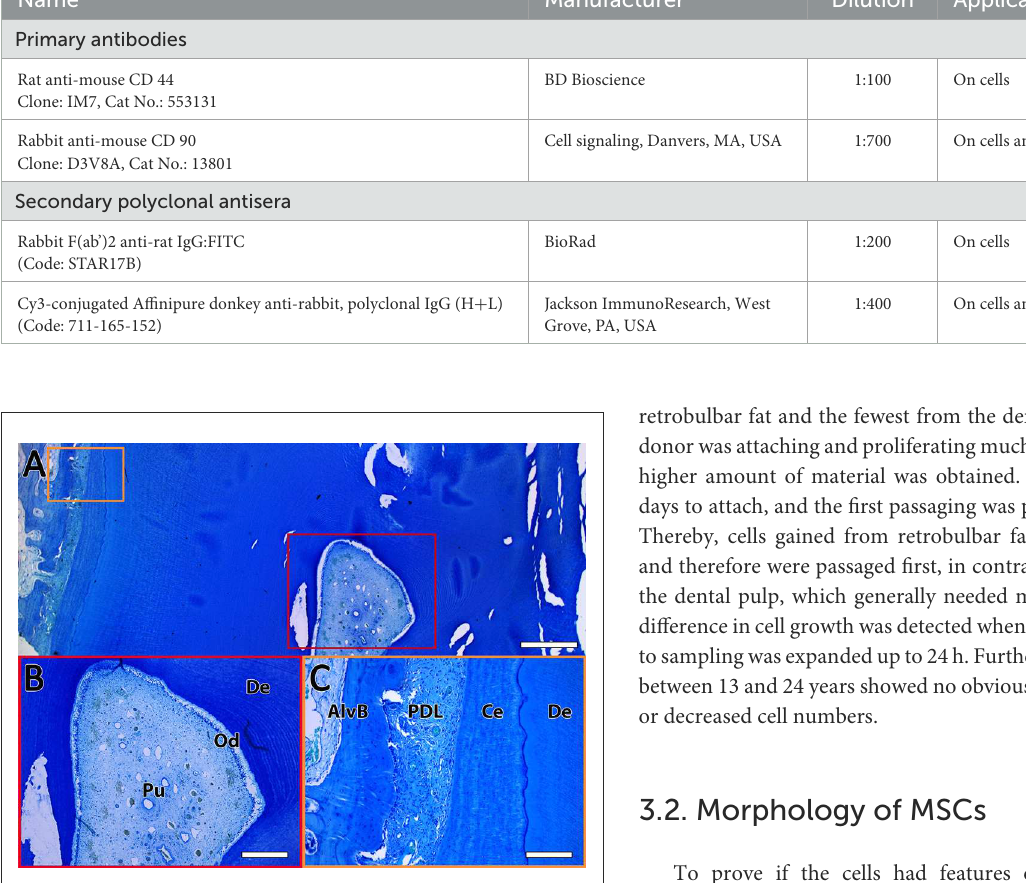
FIGURE4 Exemplary toluidine blue staining of a horizontal sectioned incisor. (A) Overview of the dental pulp (red rectangle) and the PDL (orange rectangle). The scale bar represents 1,000 µ m. (B) Enlarged view of the dental pulp (Pu) with the odontoblastic layer (Od) surrounded by dentin (De). The scale bar represents 400 µ m. (C) Enlarged view of the PDL between the alveolar bone (AlvB) and the cementum (Ce) followed by the dentin (De). The scale bar represents 200 µ